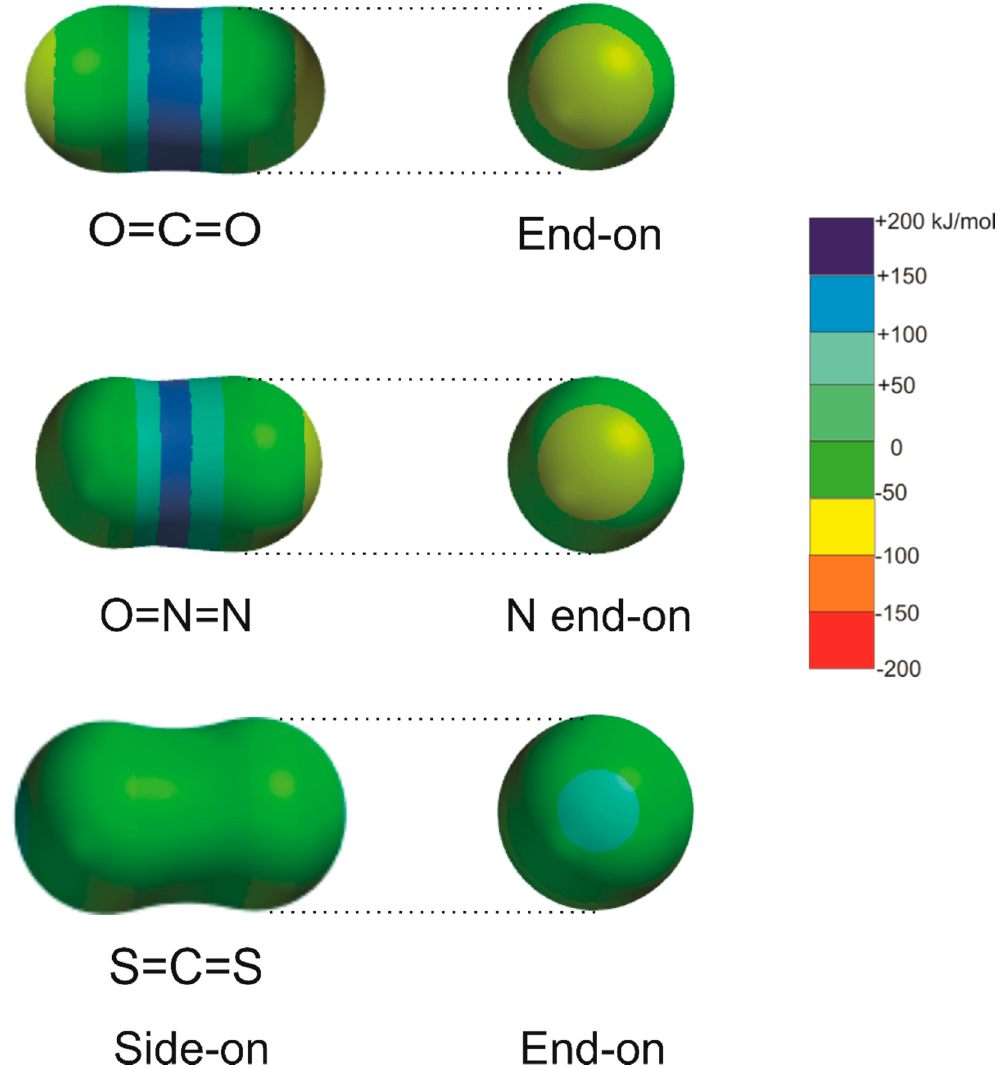
Figure 1. Molecular electrostatic surfaces potential (MESPs) for carbon dioxide, nitrous oxide, and carbon disulfide calculated for the 0.002 e/bohr 3 iso-surface at the MP2/6-311++G** level.